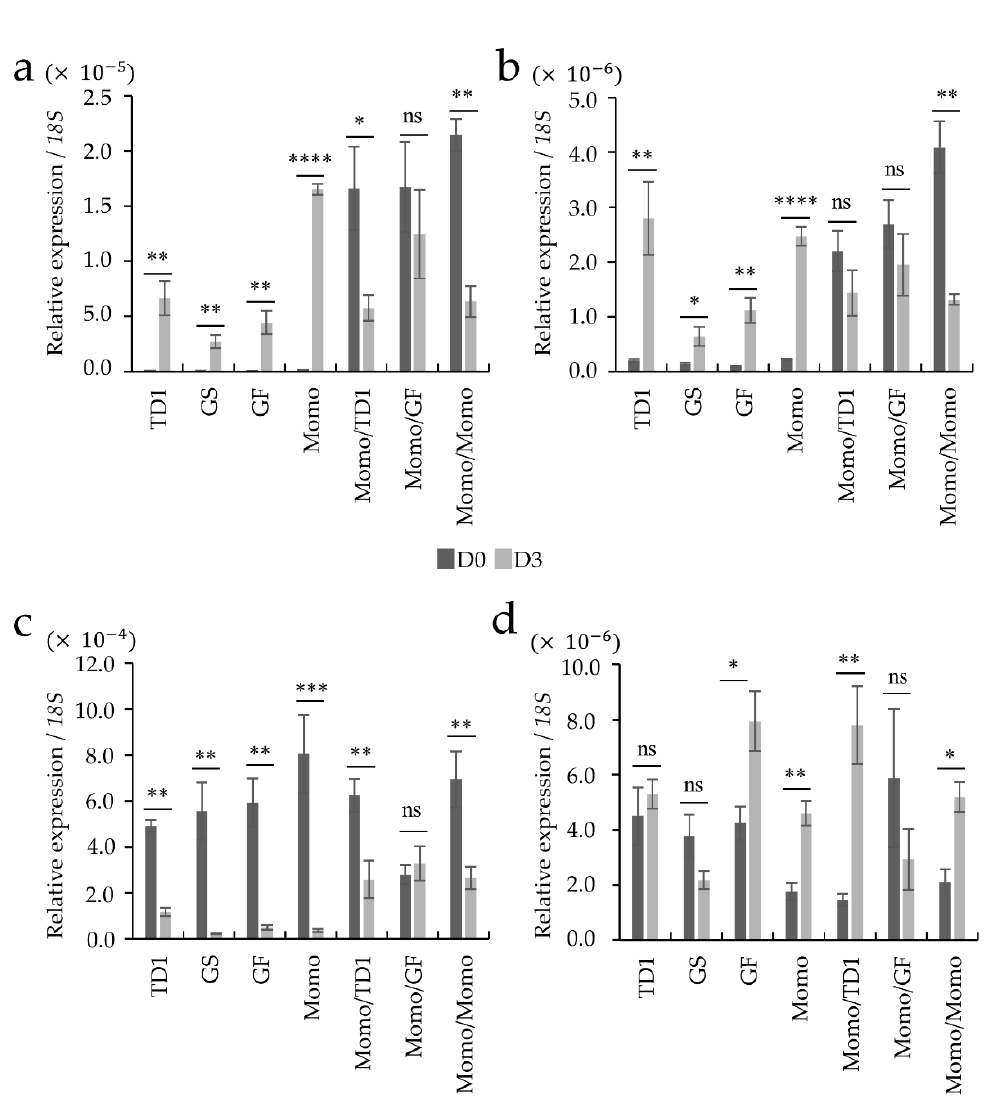
Figure 5. Changes in gene expression of 4 genes differentially expressed by grafting or drought stress assessed by quantitative real-time PCR. ( a ) Heat shock protein ( Solyc08g062450 ); ( b ) Ascorbate peroxidase ( Solyc09g007270 ); ( c ) Chlorophyll a–b binding protein ( Solyc08g067330 ); and ( d ) 9-cis- epoxycaratenoid dioxygenase ( Solyc07g056570 ). Gray bars represent before treatment (D0) and black bars represent 3 days drought stress treatment (D3). Asterisks denote significant differences according to t-test (Wilcoxon test) between D0 and D3 of each line, where * indicate p < 0.05, ** p < 0.01, *** p < 0.001, and **** p < 0.0001. No significance is denoted as ns . Error bars represent the standard error from 3 biological replicates with 3 technical replicates.